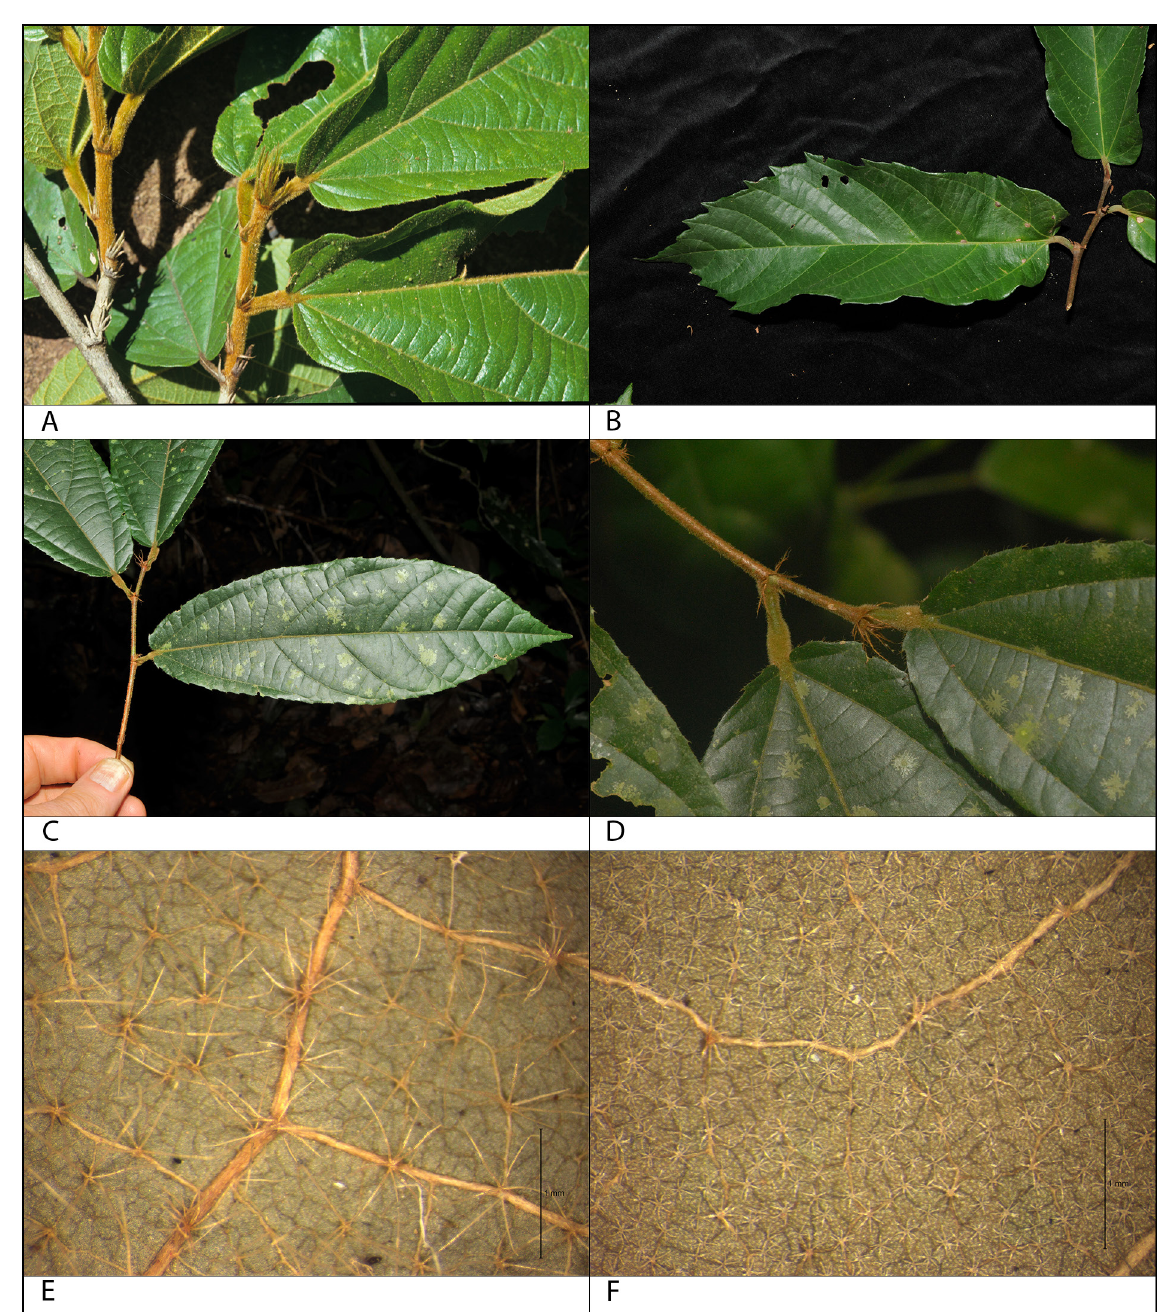
Fig. 2. Desplatsia Bocq. leaf images. A . D. chrysochlamys (Mildbr. & Burret) Mildbr. & Burret ( Harris 4977 (E)). B . D. dewevrei (De Wild. & T.Durand) Burret ( Harris 9664 (E)). C – D . D. subericarpa Bocq. ( Harris 10194 ). C . Leaves. D . Leaf base with subulately divided stipules and distinctly inflated petiole in upper part. E – F . Stellate hairs on leaf undersurface. E . D. chrysochlamys (Mildbr. & Burret) Mildbr. & Burret ( Harris 5241 (E)). F . D. mildbraedii Burret ( Harris 4397 (E)). E–F at the same magnification (40 × with microscope). Scale bars = 1 mm. A–D images by D. Harris (RBGE); E–F images by J. Wellsow